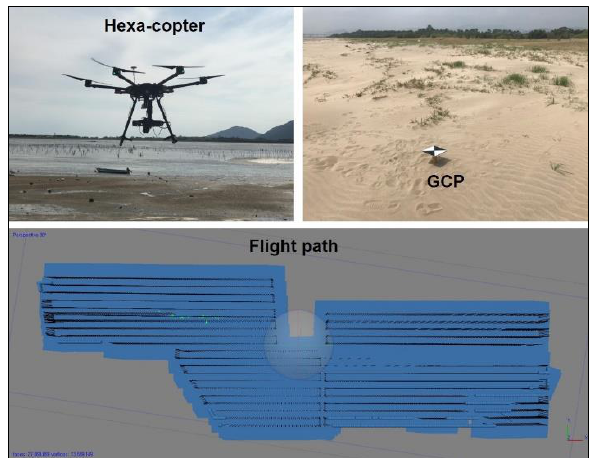
Figure 2. UAV, GCP and flight path for data